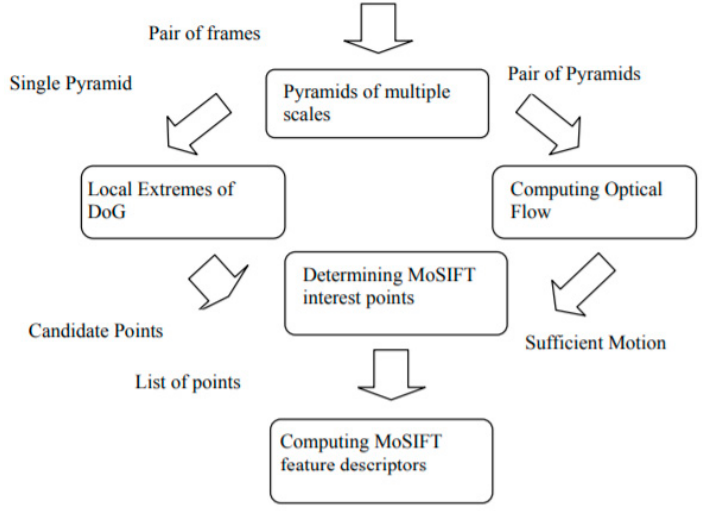
Figure 2. Image describing the stages for the calculation of points of interest.